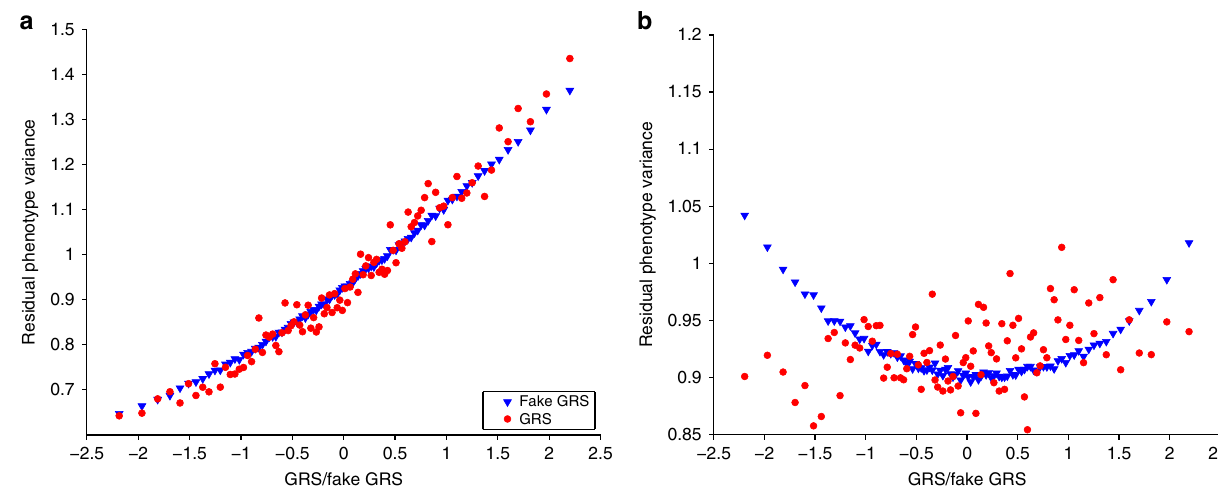
Fig. 5 Conditional variance vs GRS plots for true and fake GRS. UK Biobank participants were binned into 100 equal sized groups according to their GRS values. In each group the variance of the residual outcome (Var( Y − α 1 G − α 2 G 2 )) was calculated and plotted against the mean GRS value in the group. Similar procedure was followed for 50 fake GRSs, and the obtained variances for each bin were averaged out over the 50 repeats. Panels shows the comparison for BMI ( a ) and leg impedance ( b